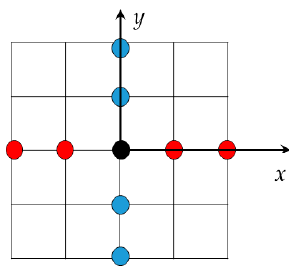
Figure 2. Two linear arrays in cross configuration that synthetize a planar antenna. In this case K N + K M elements are considered instead of K N × K M .